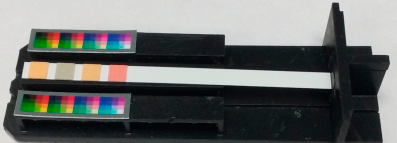
Figure 8. CIE 1976 u’ v’ color component of the high-resolution calibrated target colors (cid:2435) (cid:3043)(cid:3021) (cid:3286) .